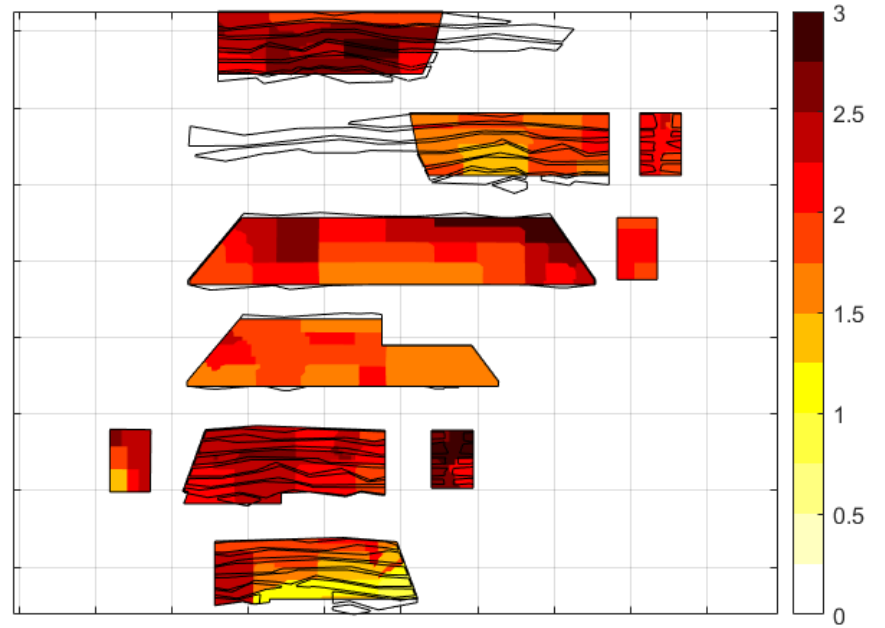
Figure 17. Envelope maps of the positive ˆ C p , measured on the inner façade of the PDSF.